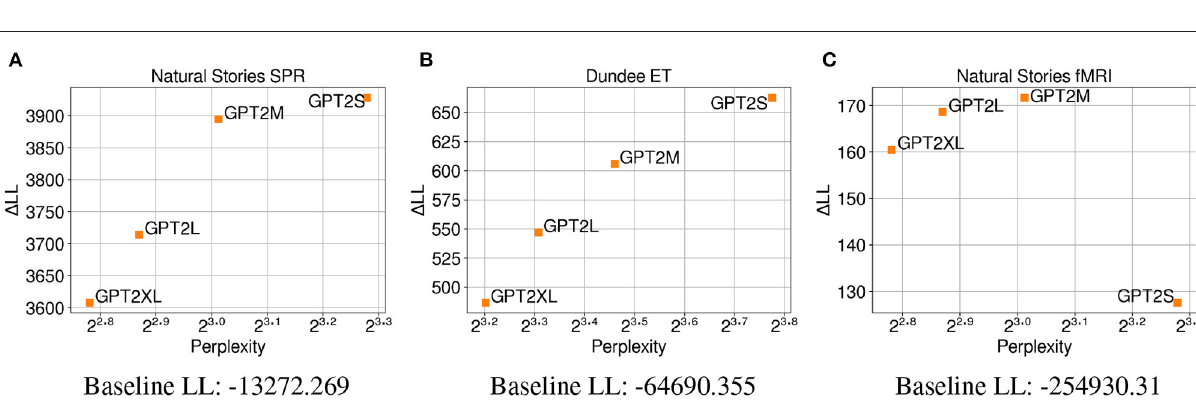
FIGURE 7 | Perplexity measures from each model, and improvements in CDR model log-likelihood from including each surprisal estimate on (A) Natural Stories self-paced reading data, (B) Dundee eye-tracking data, and (C) Natural Stories fMRI data. The difference in by-item squared error between the Structural and GPT2XL models is significant at p < 0.05 level for the self-paced reading and fMRI data.